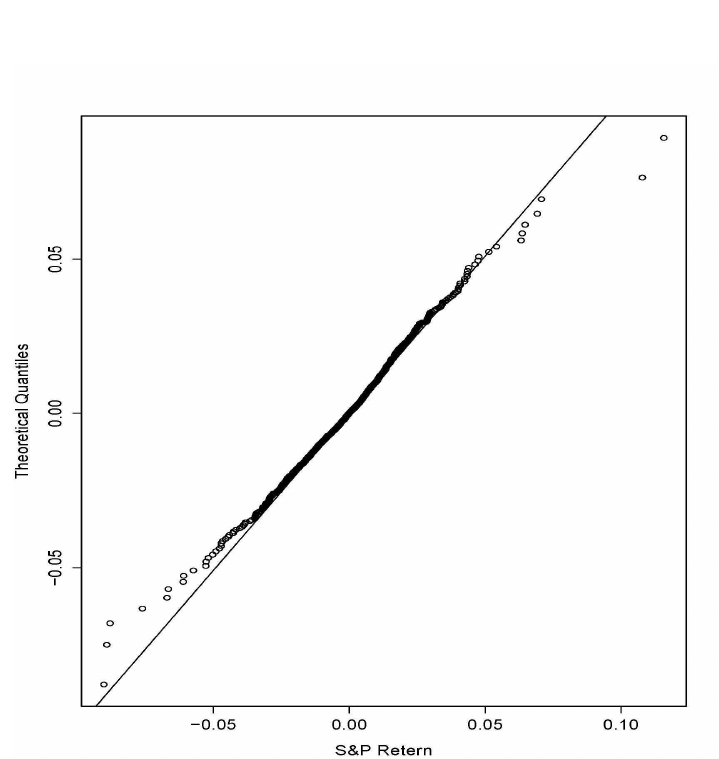
Figure 4 –: GDL probability plot. GDL probability plot of SP 500 Returns. The reference line passes through the first and third